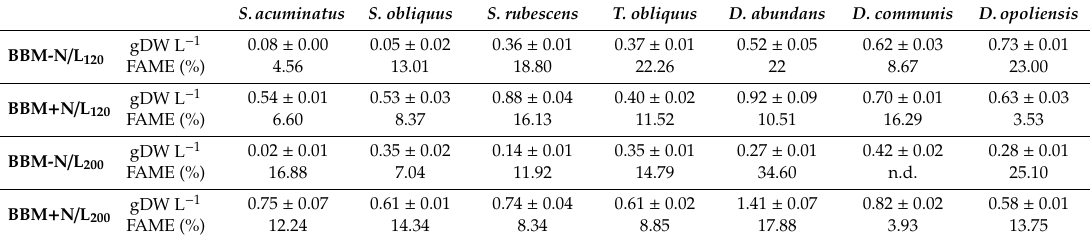
Table 1. Biomass production (in terms of gDW L − 1 ) and fatty acid methyl esters (FAME) yields (as percentage, %) obtained both for Scenedesmus, Tetradesmus and Desmodesmus strains in di ff erent culture conditions (BBM = bold basal